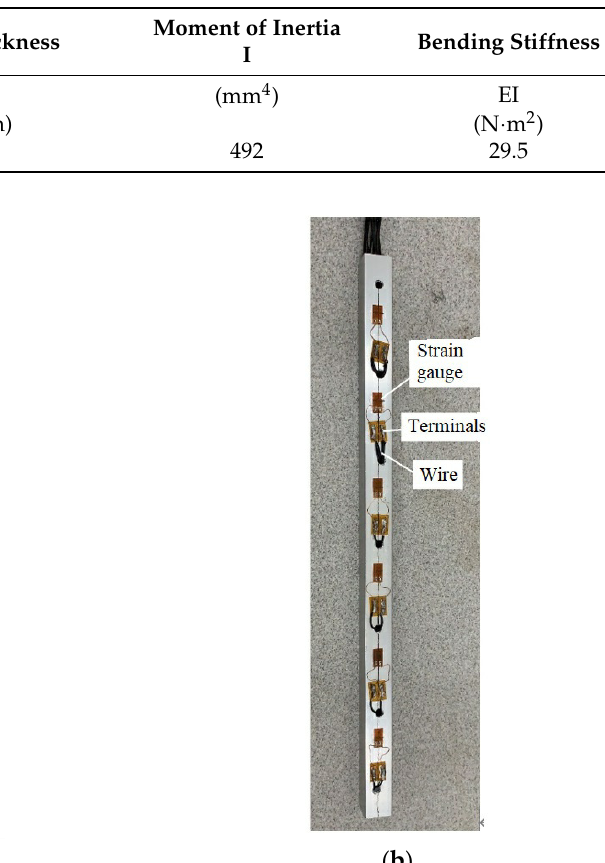
Table 2. The physical properties of the model pile material.